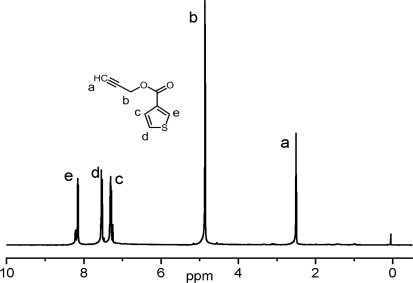
1H NMR spectrum of propargyl-thiophene.